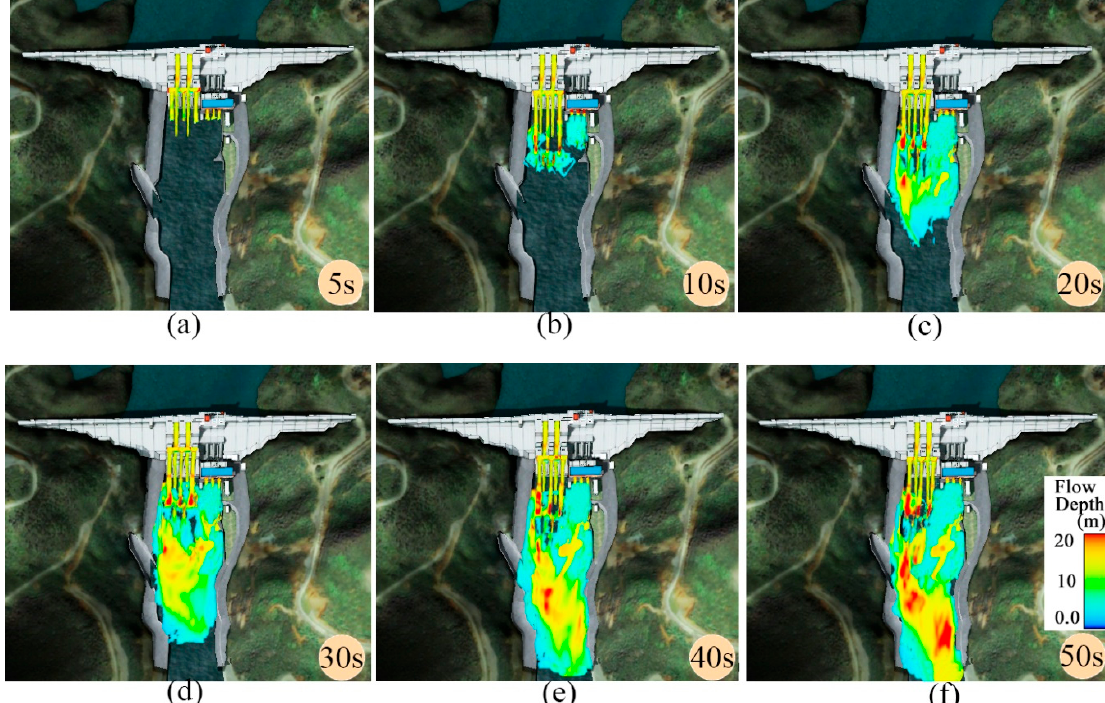
Figure 8. Water depth distribution under the normal water level. ( a ) water depth distribution at T = 5 s; ( b )water depth distribution at T = 10 s; ( c ) water depth distribution at T = 20 s; ( d ) water depth distribution at T = 30 s; ( e ) water depth distribution at T = 40 s; ( f ) water depth distribution at T = 50 s.